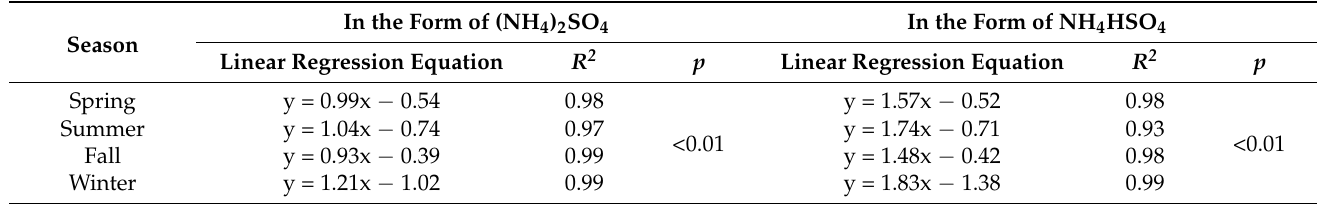
Table 3. Regression analysis between calculated values and measured values of NH 4+a